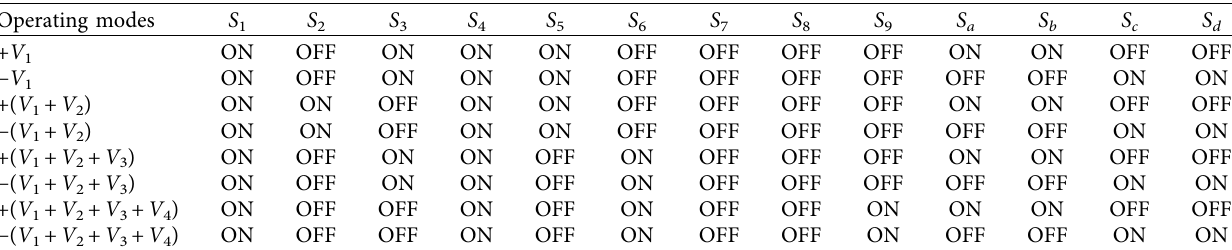
Table 1: Switching states for diferent operating modes.